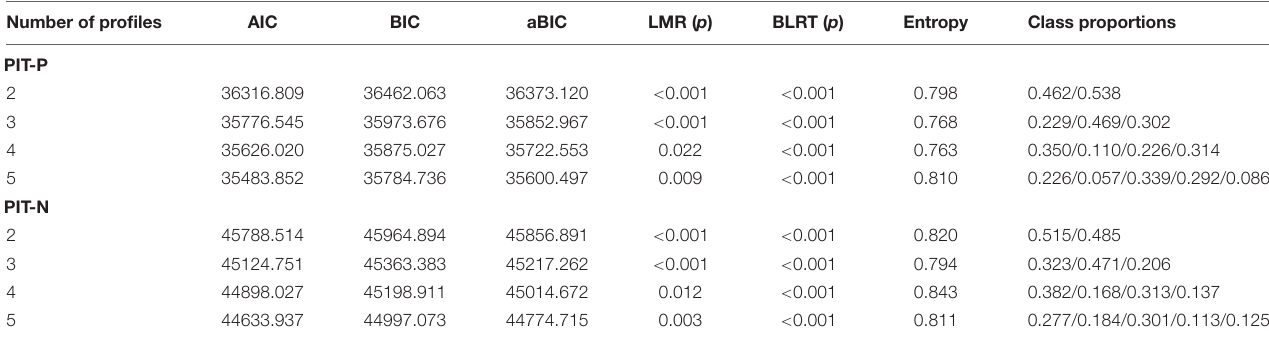
TABLE 7 | Model fit of the latent profile models.